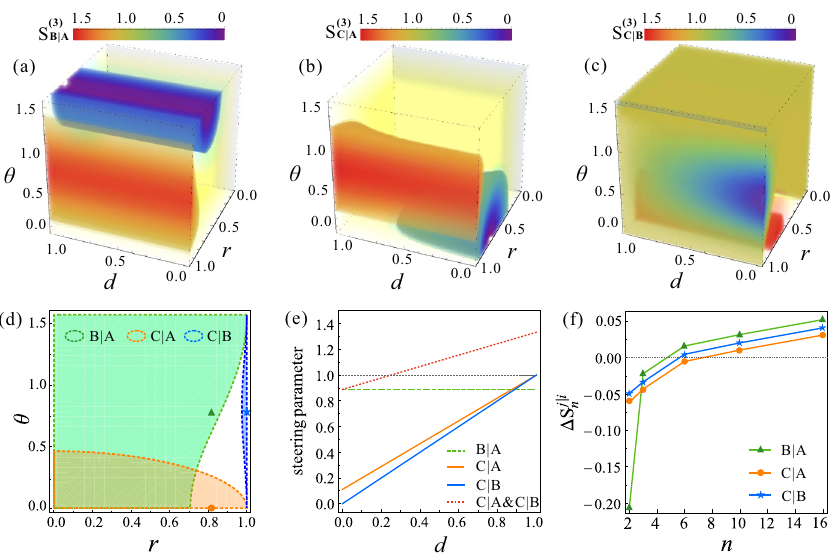
( 3 ) S ( 3 ) Figure 3. The dynamics of reduced bipartite steering under PDC. ( a–c ) The steering parameters S B A , C A | | ( 3 ) r , θ , respectively. ( d ) The reduced and S C B as functions of decoherence strength d and state parameters { } 9 / 10 . The green region enclosed by | r , θ bipartite steering regions are parameterized by for a fixed d = { } dashed green line represents Alice can steer Bob, the orange region enclosed by dashed orange line represents Alice can steer Charlie, and the blue region enclosed by dashed blue line represents Bob can steer Charlie. ( 3 ) 0 ) (orange ( r ( r π/ 4 ) (green dashed line), S ( 3 ) √ 2 / 3, θ √ 2 / 3, θ ( e ) The steering parameters S B A C A = = = = | | ( 3 ) 1, θ ( r π/ 4 ) (blue line) and S ( 3 ) ( r π/ 4 ) (red dashed line) as a function of d . √ 2 / 3, θ line), S C B C B ( A ) = = = = | | j i j i ( f ) The difference between S | | n and C n ( (cid:31) S n ) for the three reduced bipartite states marked as green triangle 0 ), blue star ( r 1, θ 9 / 10 . π/ 4 ), orange circle ( r π/ 4 ) in ( d ) for a fixed d √ 2 / 3, θ √ 2 / 3, θ ( r = = = = = = = B , C S j | i n > C n indicates the existence of the corresponding reduced bipartite steering, where i A , B , j . ∈ { } ∈ { } 1 / 4 (red dashed line), which decays faster than lie and that from Bob to Charlie completely disappear at d = 1, θ 0 ) and S ( 3 ) ( r ( r π/ 4 ) . √ 2 / 3, θ S ( 3 ) C A C B = = = = | | To illustrate the advantages of the average conditional variance-based steering criterion, we further consider the ability of party i to steer party j by using the n -setting linear steering inequality, which is represented as j i j i j i local hidden state model. Figure 3f presents the difference between S | | | n = S n − C n ) for the reduced n and C n ( (cid:31) S 0 , the 9 / 10 . If � S j | i bipartite states marked as green triangle, orange circle, blue star in Fig. 3d for a fixed d n > = j i 0 is more than steerability is demonstrated. We find that the number of the measurement settings for � S | n > 3 , the corresponding reduced bipartite steerabilities shown in Fig. 3e have not disappeared three, and when n = completely, which means the steering criterion based on average inference variance is more efficient.